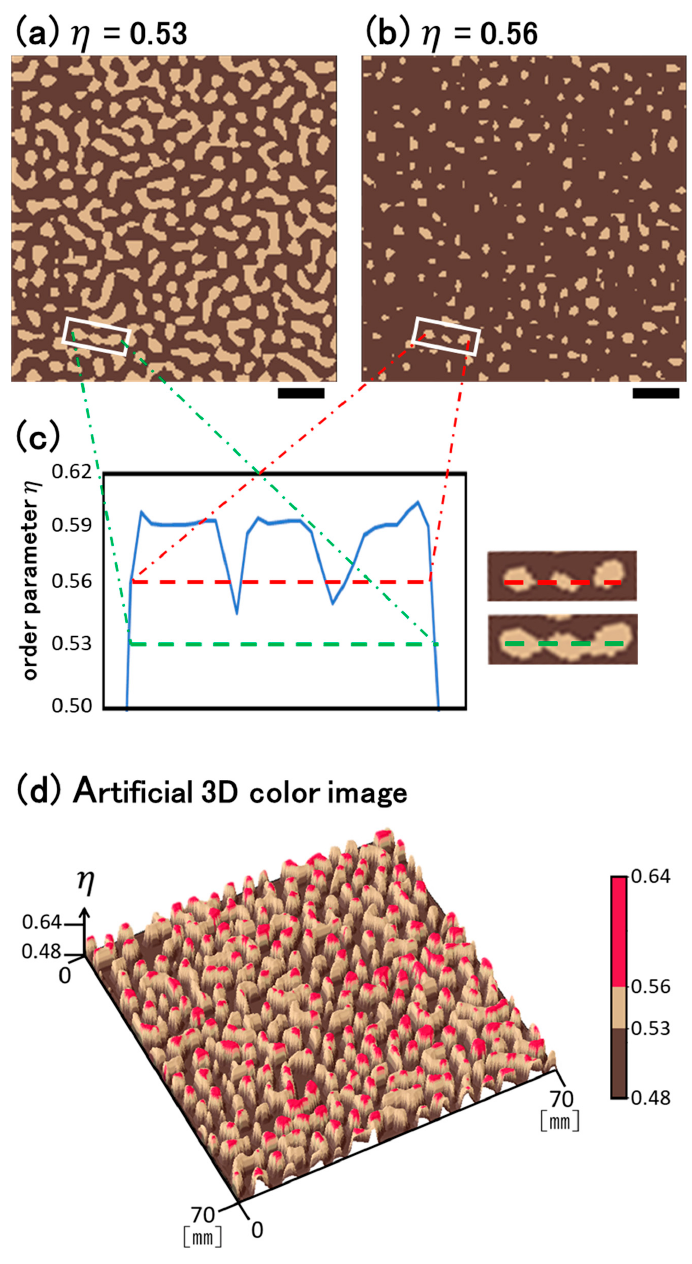
Figure 3. Segregation pattern obtained from numerical simulation for phase-segregation with the simple model equations (Equations (1)–(3)). The scale bars are 10 mm. ( a , b ): Spatial patterns with different threshold values of the parameter, η = 0.53 and 0.56, respectively, both of which correspond to the pattern generated after 130 s from the start of segregation. The bright parts in ( b ) show the region that is more water-rich than that in ( a ). ( c ): Order parameter along a section as indicated by a green bar in ( a ) and a red bar in ( b ), which are chosen from the spatial patterns in ( a , b ). ( d ): Artificial 3D color image on the same numerical simulation as in ( a , b ), revealing the existence of mini water-rich spots on the upper part (larger η value) of the waggly pattern.